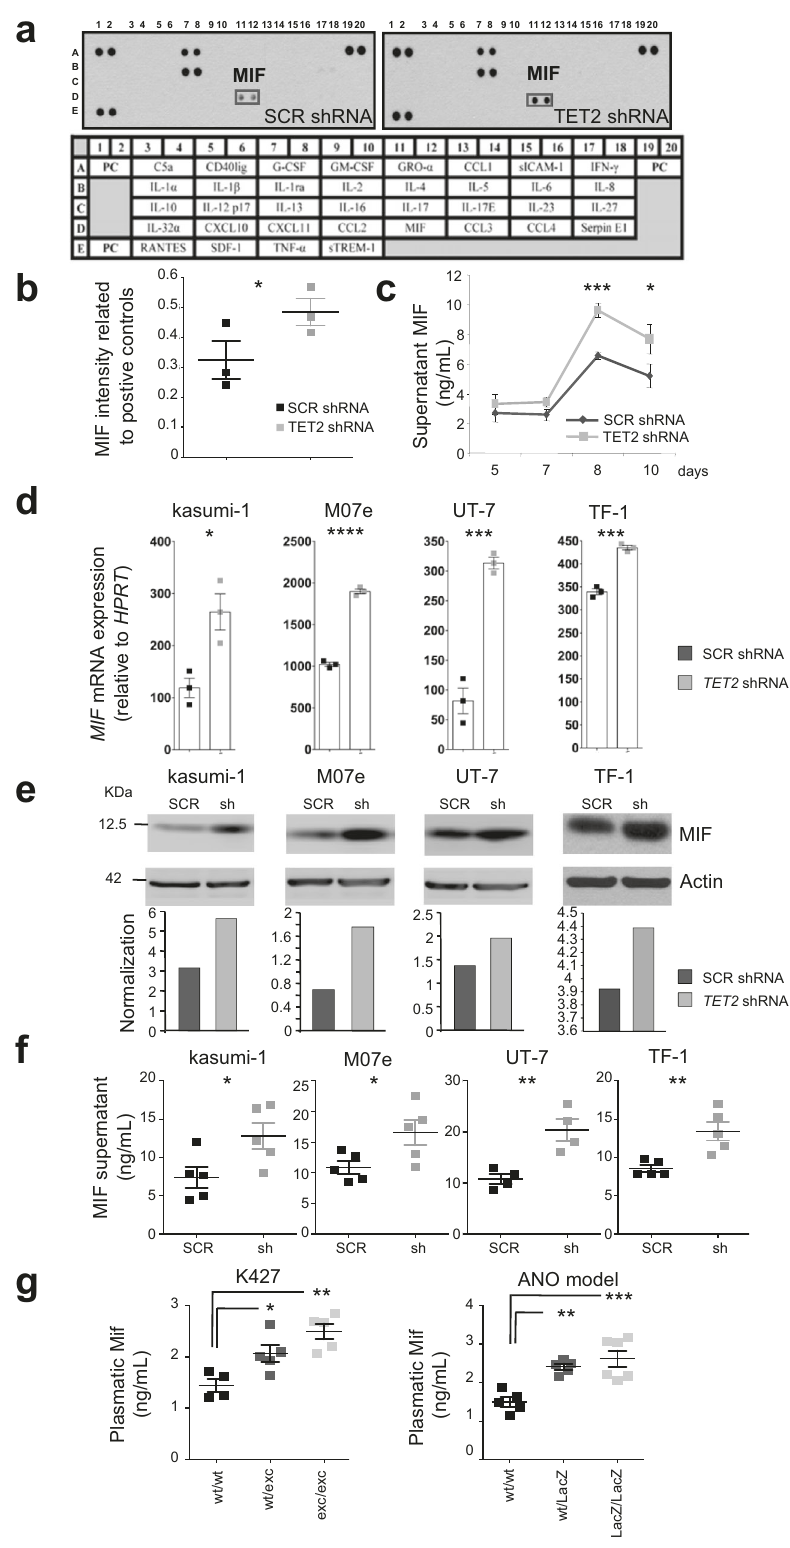
non-truncated variants ( non-trTET2 MUT ), i.e., in frame insertion/ deletion, missense, and splice site variants 19 . From our RNA sequencing data, the decreased expression of TET2 gene expression observed in trTET2 MUT cells correlated with an increased expression of MIF mRNA, which was not detected in COMMUNICATIONS BIOLOGY| (2022) 5:110